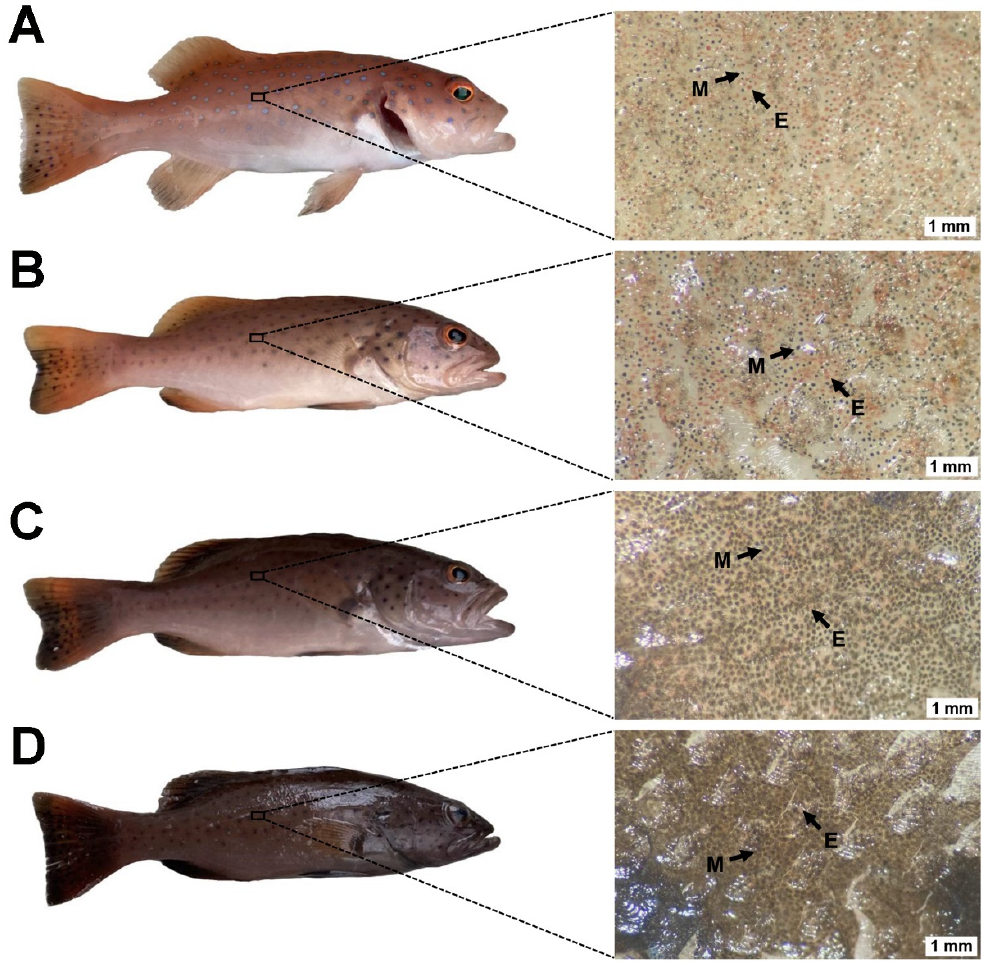
Figure 1. Skin color phenotypes under different backgrounds and the chromatophore types in P. leopardus : ( A ) initial, ( B ) white background, ( C ) blue background, ( D ) black background; the letter E marks erythrophores, and the letter M marks melanophores.